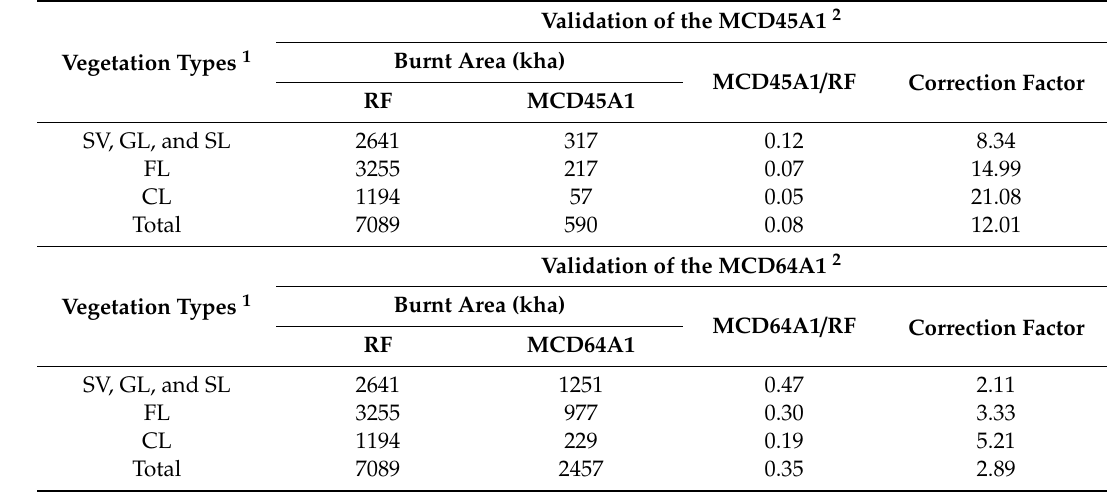
Table 5. General results of the validation of the MCD45A1 and MCD64A1 and the reference